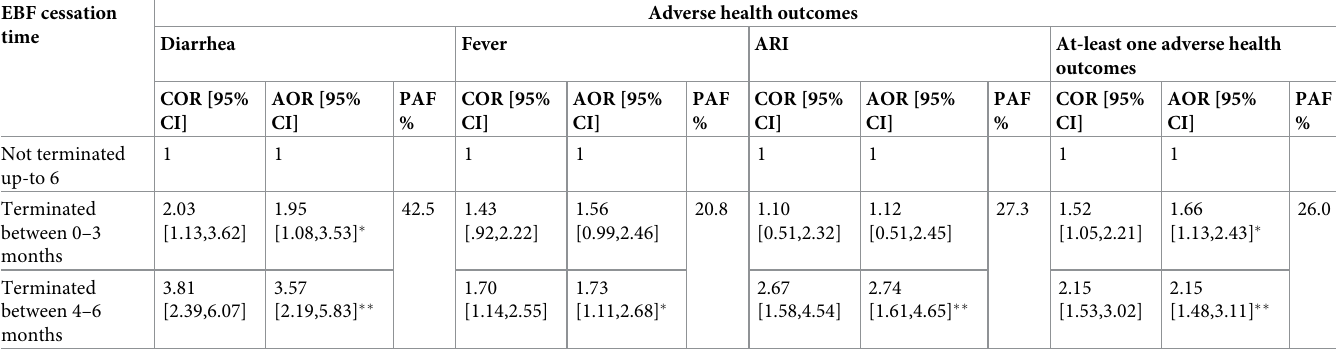
Table 3. Effect of exclusive breastfeeding on adverse health outcomes among children, 2011 and 2016 EDHS, Ethiopia.